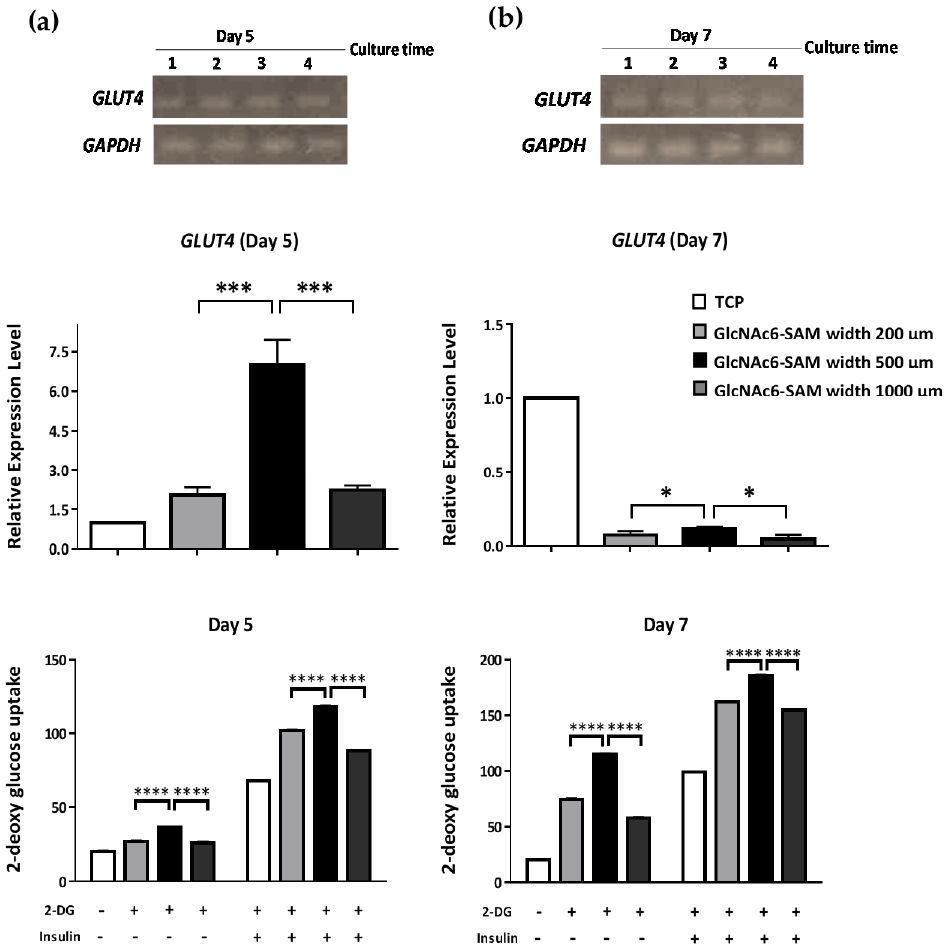
Figure 3. Micropatterned GlcNAc6-SAMs induce GLUT4 mRNA expression in differentiated C2C12 cells through contraction-dependent glucose uptake. Myoblasts were stimulated with (+) or without ( − ) 1 µM insulin, and glucose uptake rates were measured. Data were obtained after ( a ) five days and ( b ) seven days. Results are presented as the mean ± standard error of the mean (SEM) from triplicate measurements and are representative of three independent experiments. Lane 1: tissue culture polystyrene (TCPS); Lane 2: GlcNAc6-SAM pattern (200 µm); Lane 3: GlcNAc6-SAM pattern (500 µm); Lane 4: GlcNAc6-SAM pattern (1000 µm). Values were analyzed by the t -test, * p < 0.05, *** p < 0.001 and **** p < 0.0001.